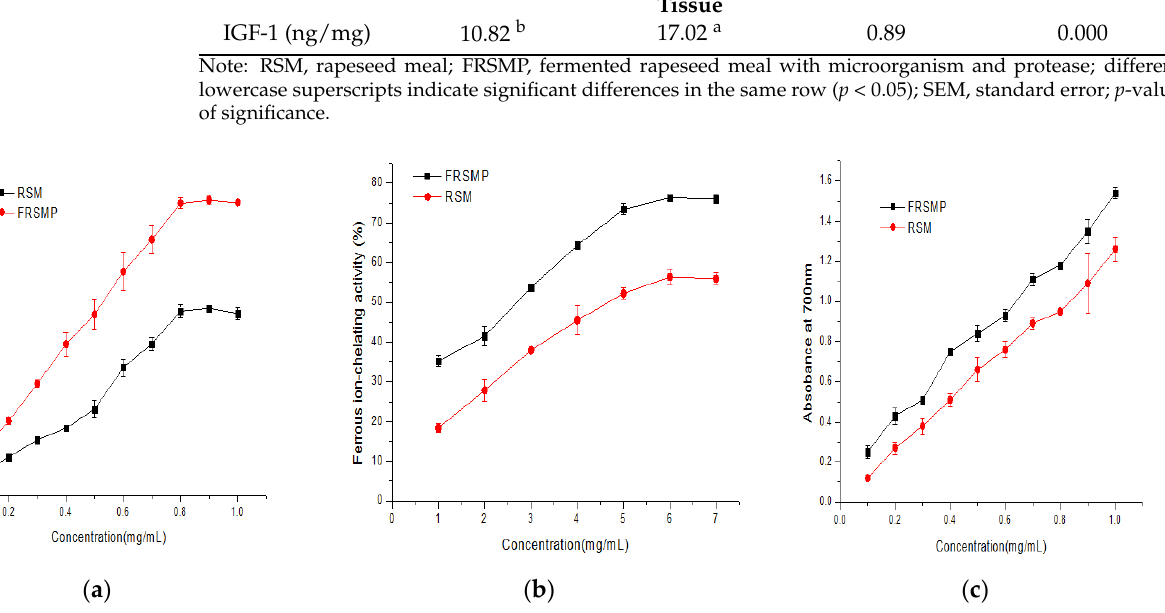
Figure 7. Antioxidant activities of the rapeseed meal (RSM) and fermented rapeseed meal with acid protease (FRSMP). ( a ) DPPH scavenging activity; ( b ) ferrous-ion-chelating activity; ( c ) reducing power.